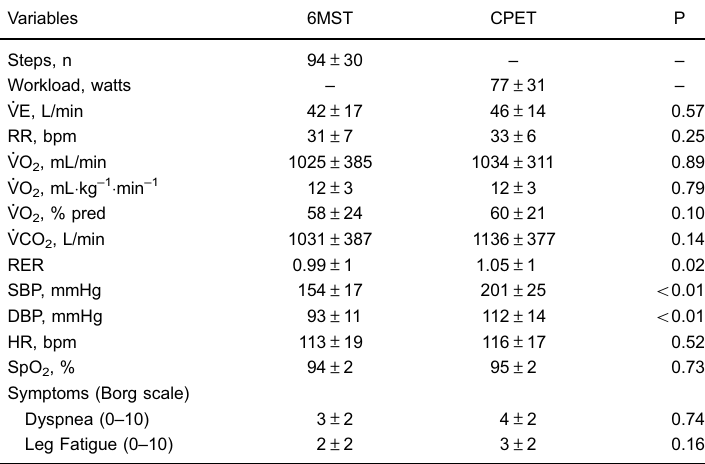
Table 3. Ventilatory, cardiovascular, metabolic, and perceptual responses at peak cardiopulmonary exercise test (CPET) and in the six-minute step test (6MST) in heart failure with reduced ejection fraction (HFrEF)